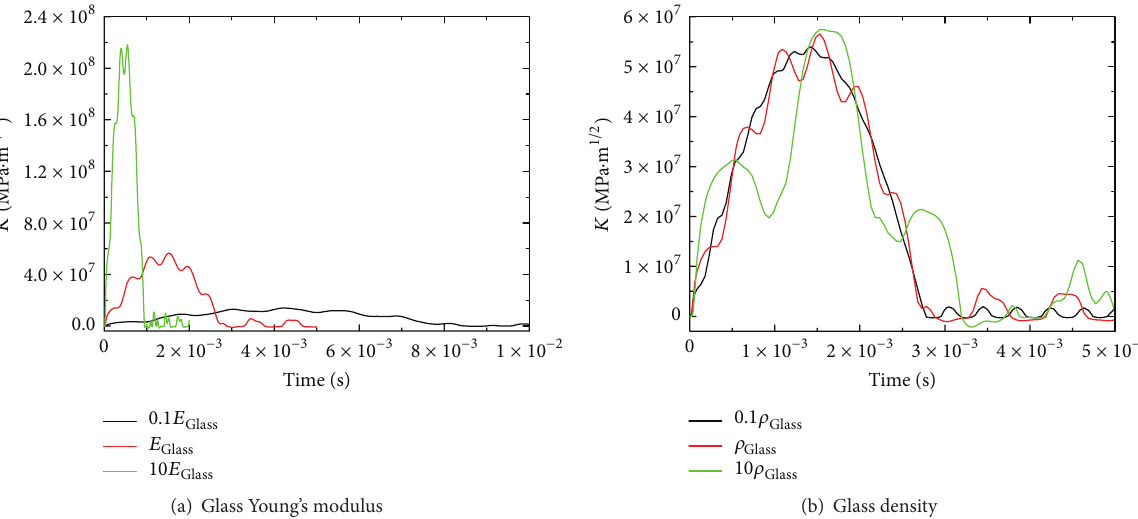
Figure 13: Mode I DSIF at node 1 of different glass properties with the impact velocity of 5 m/s and crack length of 0.02 m.